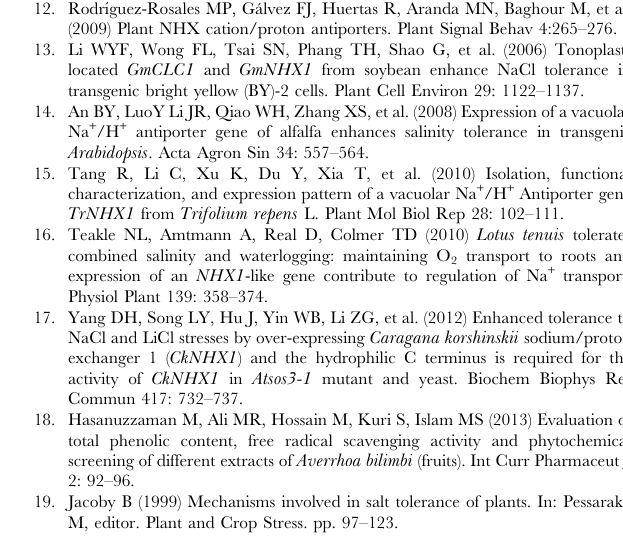
Table S1 The putative post-translational modification sites predicted by ScanProsite software for